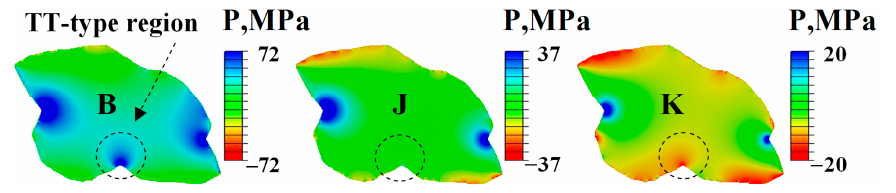
Figure 10. Stage 1 of the stress–strain curves of composites. Initial sections of the stress–strain curves of Al6061T4-WC composite, Al6061T4 matrix and WC particle ( a ), and the composites with different matrix materials ( b ). States B, J and K are shown in Figures 7–9 and 11.